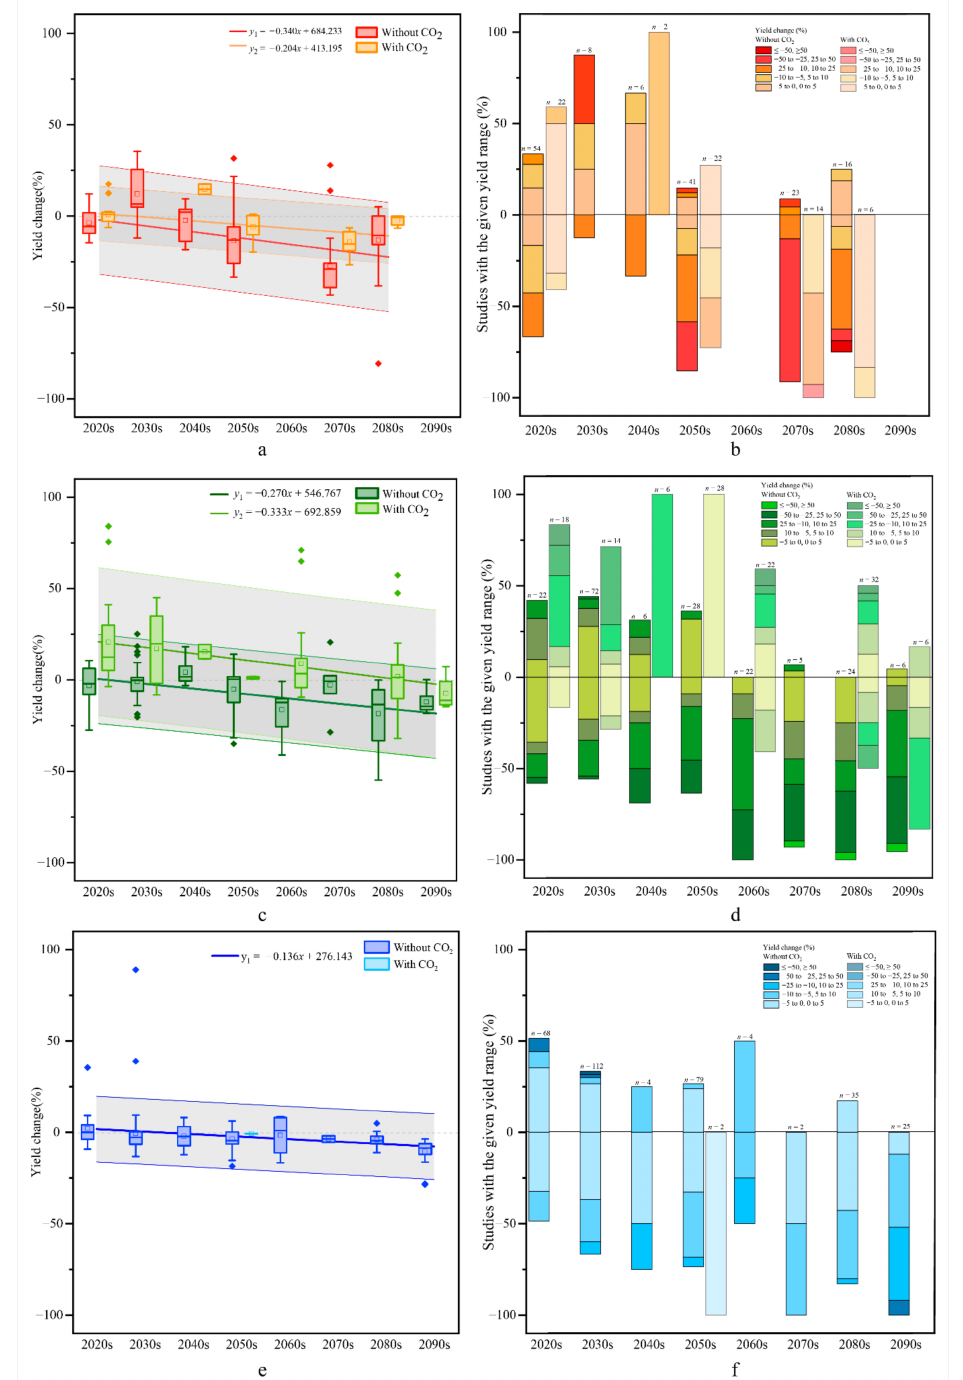
Figure 4. Temporal trend and consensus of maize ( a , b ), rice ( c , d ) and wheat ( e , f ) yield changes in